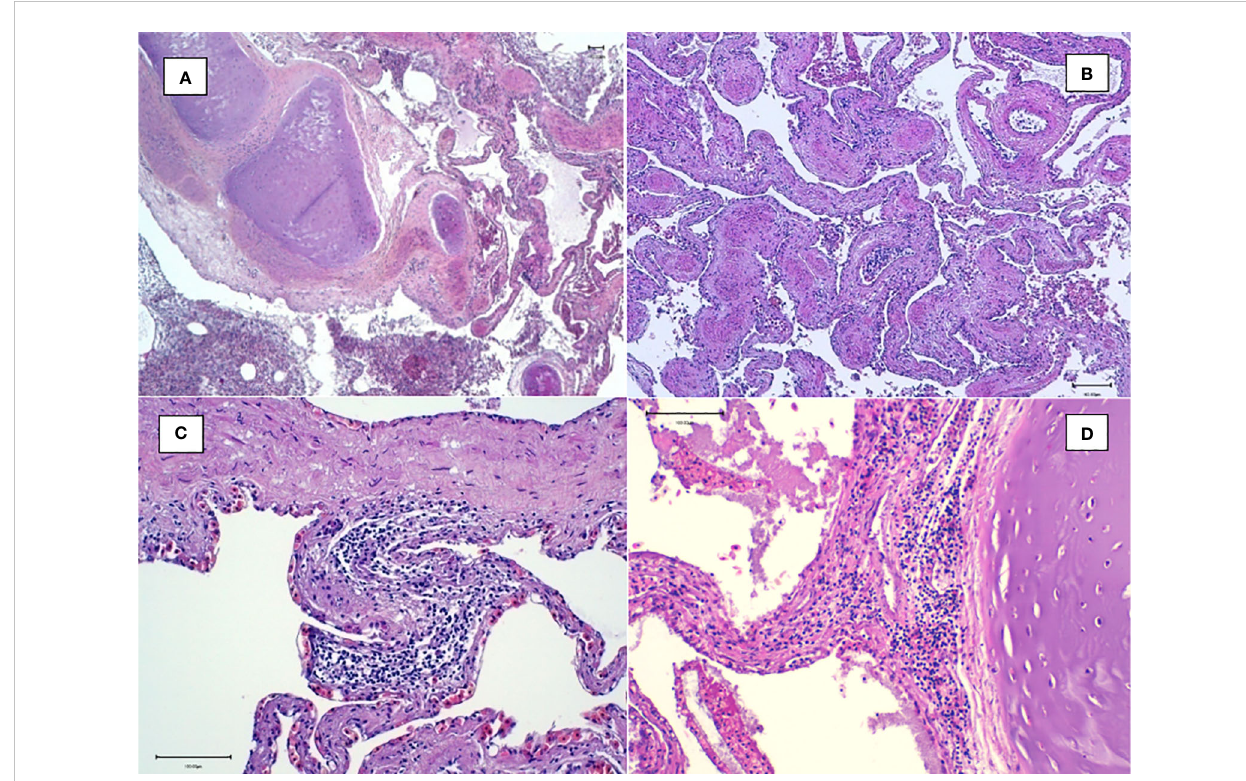
FIGURE 7 Histological examination of the lungs. (A) Magni fi cation at ×4: multifocal in fl ammatory reaction of the airways containing sloughed epithelial cells. (B) Magni fi cation at ×10: congestion and in fl ammation foci in the interfoveolar interstitium. (C, D) Magni fi cation at ×20: heterophilic in fl ammatory peribronchial foci with the presence of lymphocytes and heterophils in the interfoveolar